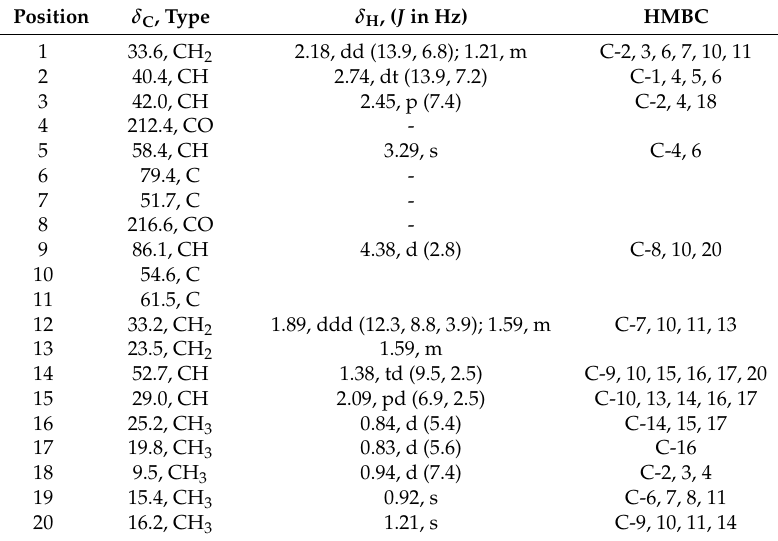
a Assignments ( δ values) were confirmed by the HSQC and HMBC experiments.